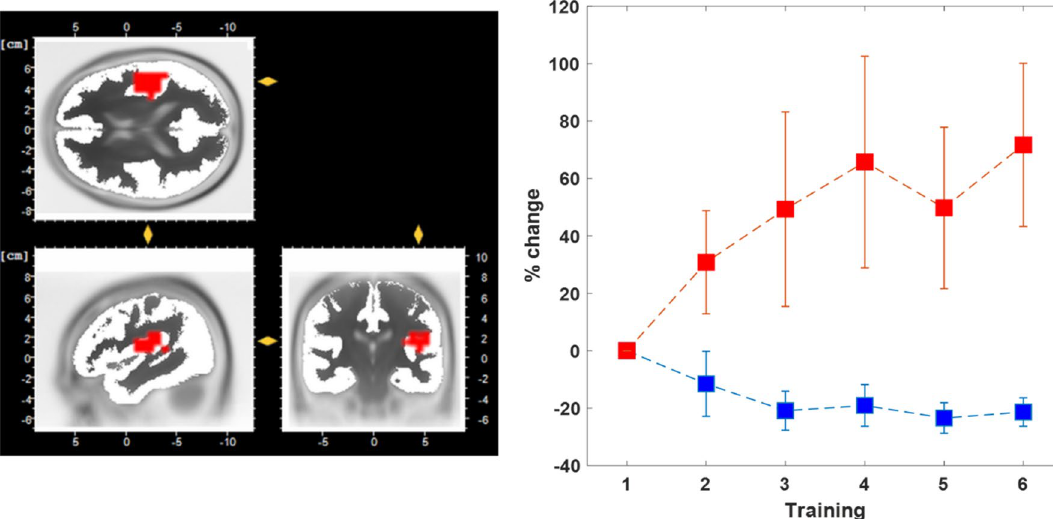
Figure 1. Region of interest in the right insula used to extract theta-band power online (left). Change of insula source space EEG power in theta-band (3–7 Hz) for up-training (red) and down-training (blue) groups (right). Depicted are percent change across training sessions 2–6 relative to the first training session. Error bars depict ± 1 standard error of the mean (SEM, n = 10 in every